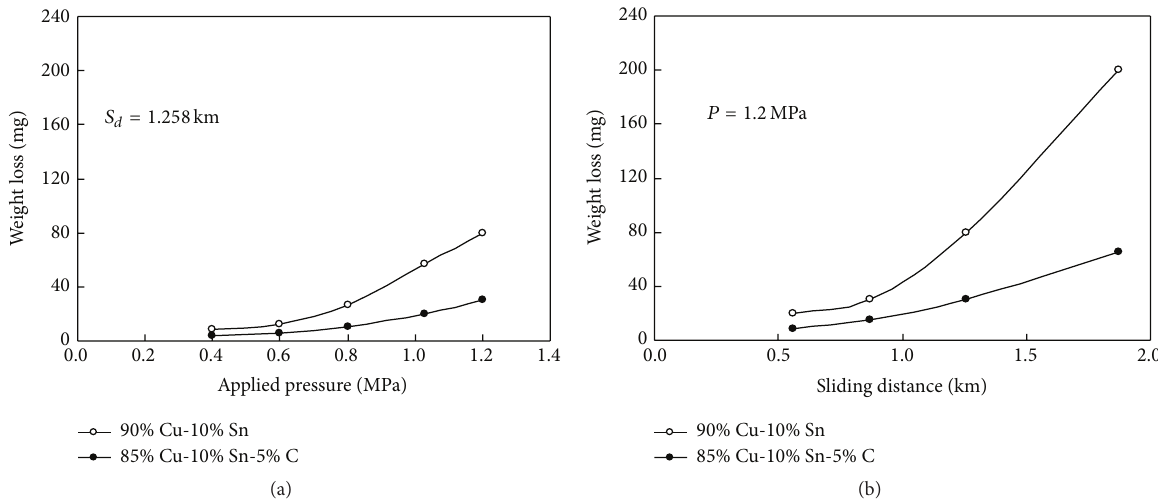
Figure 6: Weight losses in (mg) versus the applied pressure in MPa and the sliding distance in Km for the heat-treated (a) 90% Cu-10% Sn and (b) 85% Cu-10% Sn-5% C alloys.